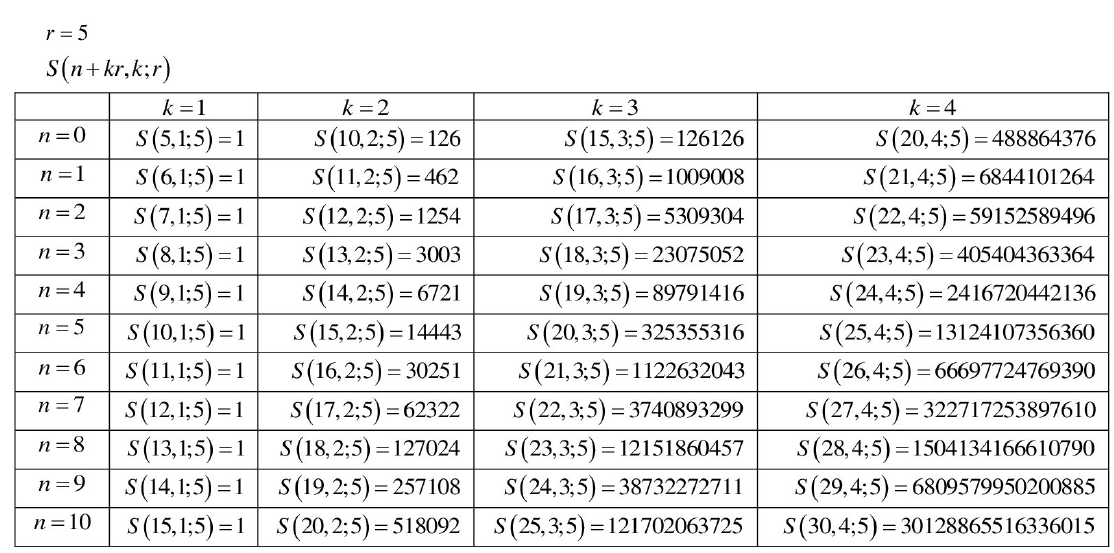
Figure 8. Numbers S ( n + 5 k , k ;5 ) , k = 1,2,3,4; n = 1,2, . . .